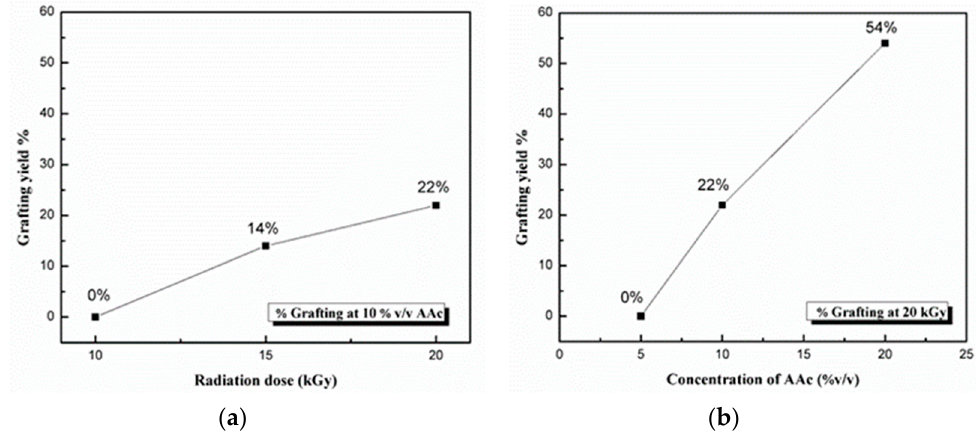
Figure 2. Factors a ff ecting grafting yield percent. ( a ) E ff ect of di ff erent gamma irradiation doses Figure 2. Factors affecting grafting yield percent. ( a ) Effect of different gamma irradiation doses (kGy) on the grafting yield%; ( b ) E ff ect of di ff erent AAc monomer concentrations (% v / v ) on the (kGy) on the grafting yield%; ( b ) Effect of different AAc monomer concentrations (% v / v ) on the grafting yield %. grafting yield